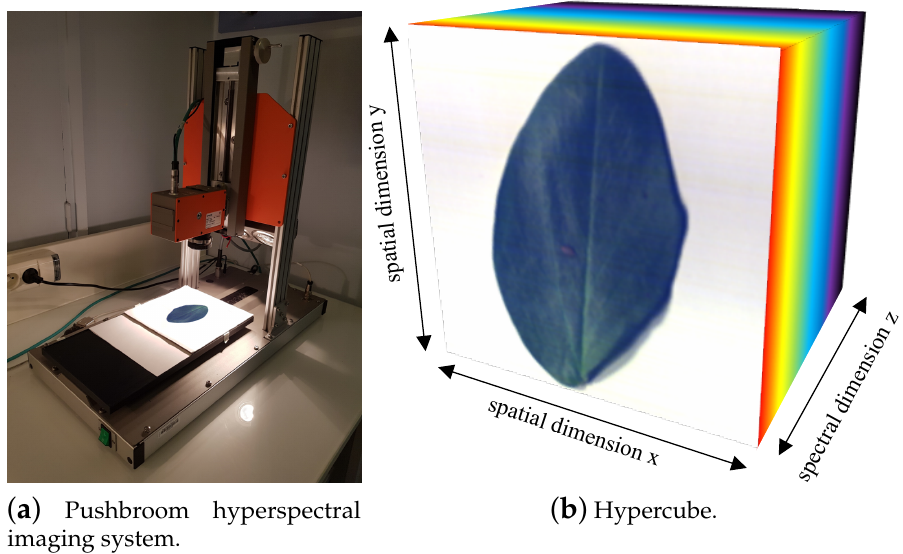
imaging system. Figure 2. Pushbroom HSI ( a ) for hyperspectral image acquisition, combining the spatial and spectral dimensions ( b ). The spatial X and Y axes and the spectral Z axis form a hypercube.